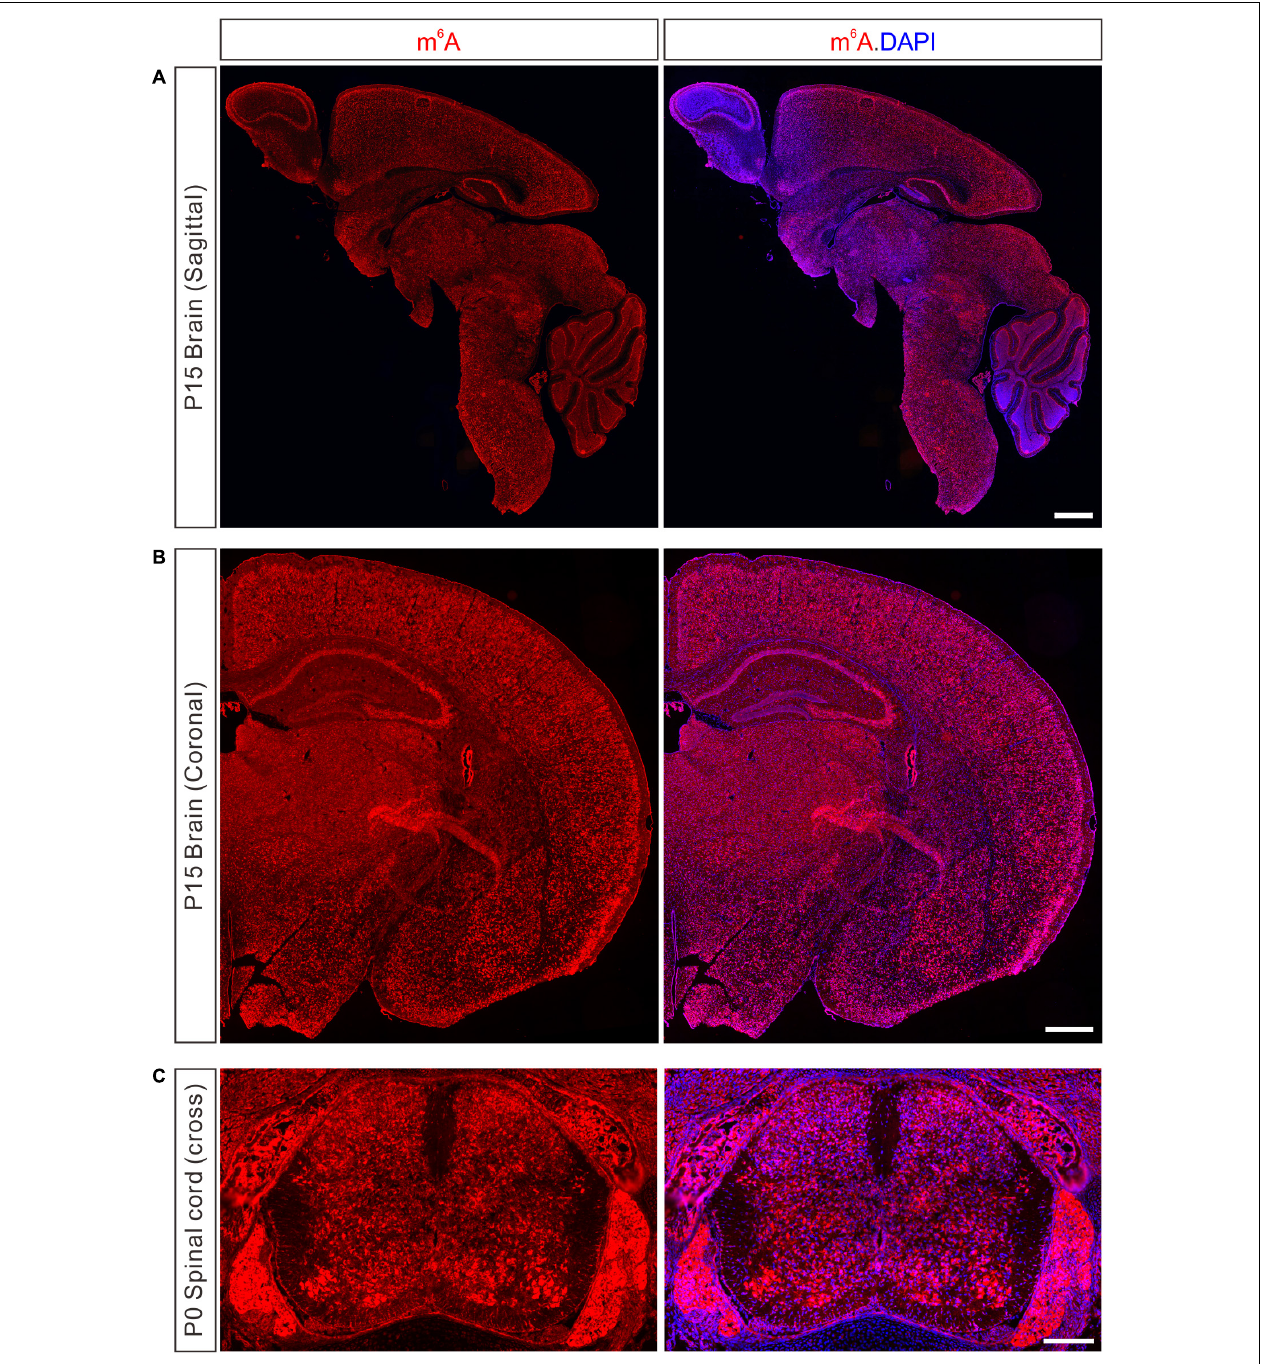
FIGURE 1 | Detection of m 6 A modification in the developing nervous system of mouse. (A) Immunostaining of m 6 A in sagittal section of P15 mouse brain. Scale bar, 1 mm. (B) Immunostaining of m 6 A in coronal section of P15 mouse brain. Scale bar, 500 µ m. (C) Immunostaining of m 6 A in cross-section of P0 mouse spinal cord and DRG. Scale bar, 200 µ